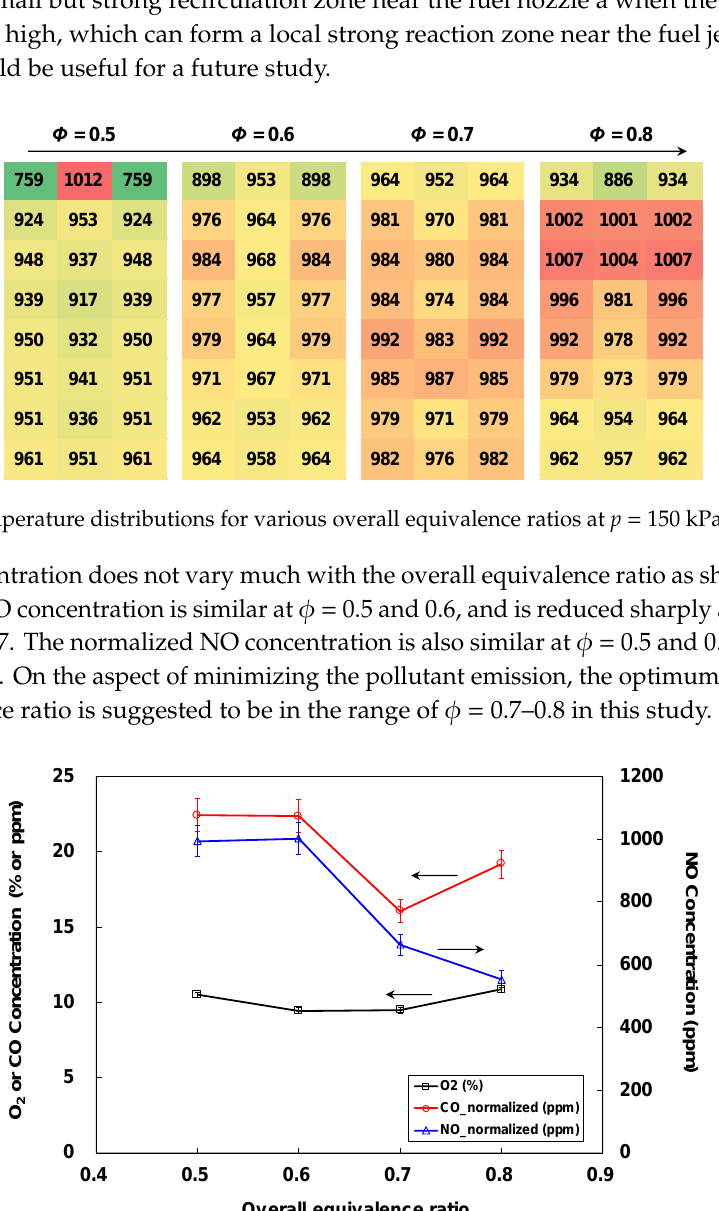
Figure 11. O 2 concentration (%), normalized CO and NO concentrations (ppm) for various overall equivalence ratios at p = 150 kPa and S = 4.56.